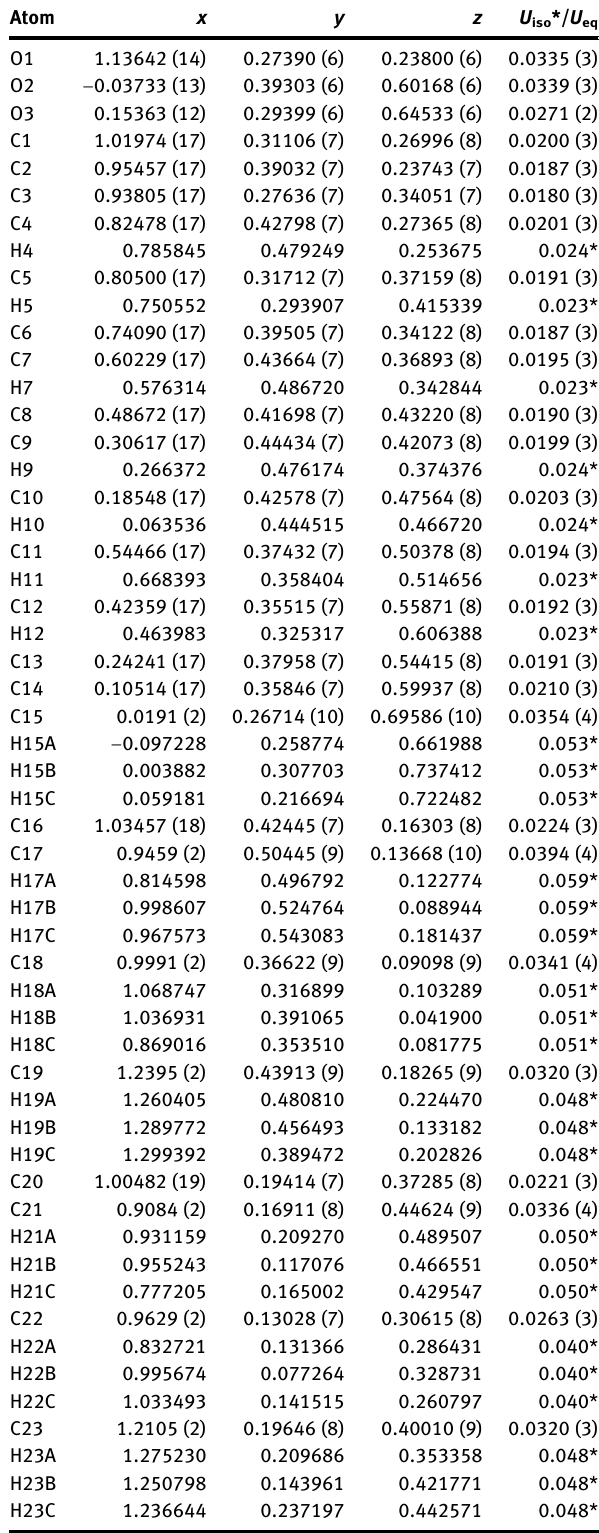
Table  : Fractional atomic coordinates and isotropic or equivalent isotropic displacement parameters (Å  ). Since all hydrogen atoms in this structure are not conformational isomers, * is used to distinguish all hydrogen